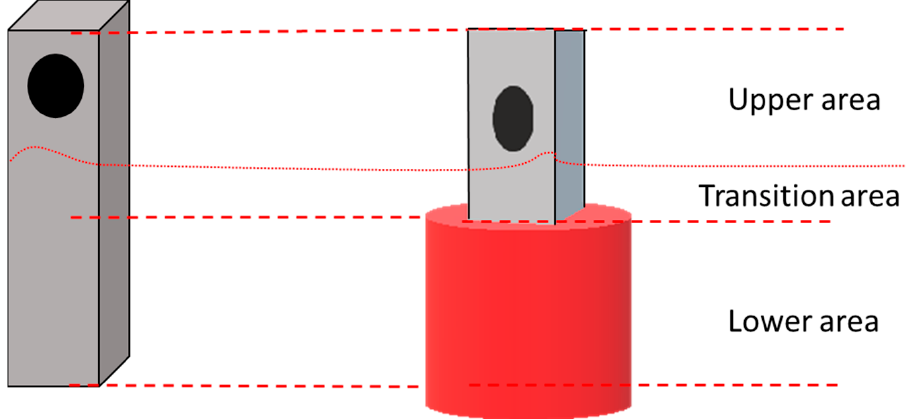
Figure 1. The image shows the three area of the sampe which are invstigated .